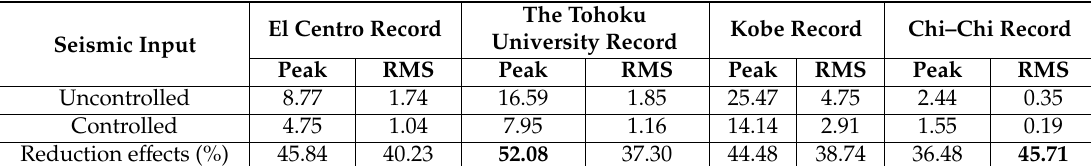
Table 2. Acceleration responses at the roof of the test frame (m/s 2 ).